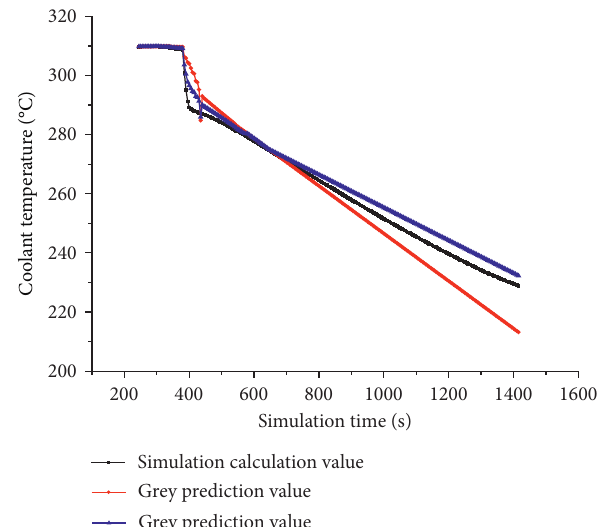
Figure 16: The comparison of the actual and predicted data of the coolant temperature.